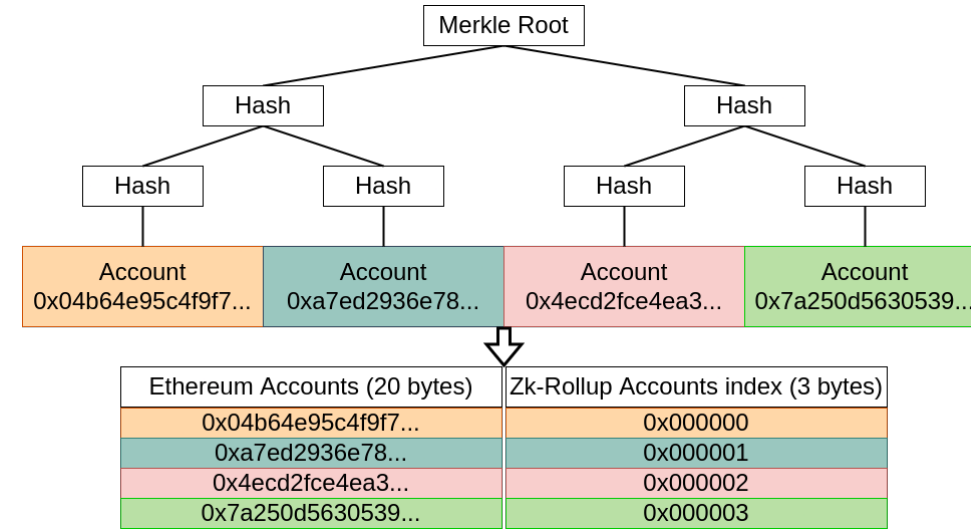
Figure 2. Representation of Ethereum accounts on a